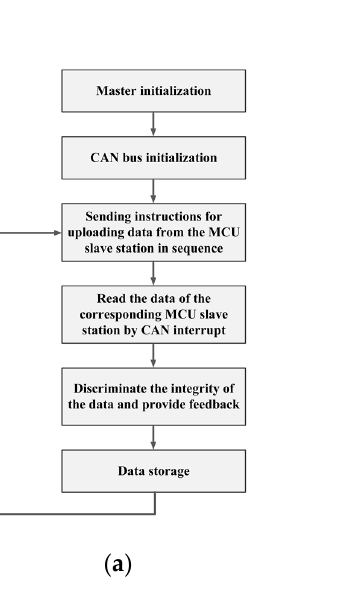
Figure 5. ( a ) Master station flow diagram; ( b ) Slave station flow diagram.